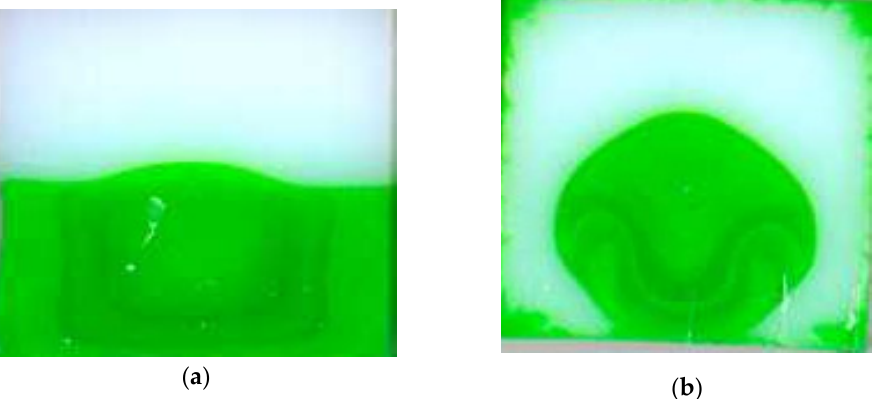
Figure 7. Typical encapsulation for the coextrusion flow of two different polystyrenes (white colored on the top and green colored on the bottom): ( a ) die entrance; ( b ) die exit (Photography reprinted from Ref.